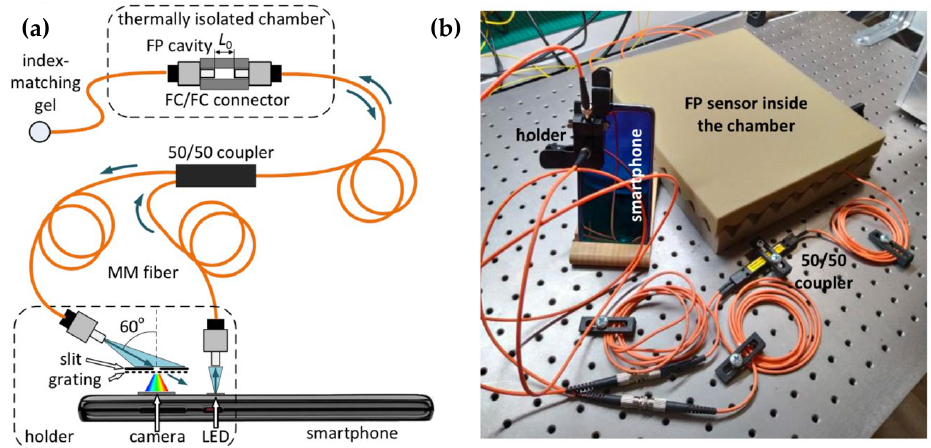
Figure 12. Schematic representation ( a ) and photograph ( b ) of the smartphone optical fiber sensing system for Fabry–Perot sensor interrogation (image reproduced from [106] ) .